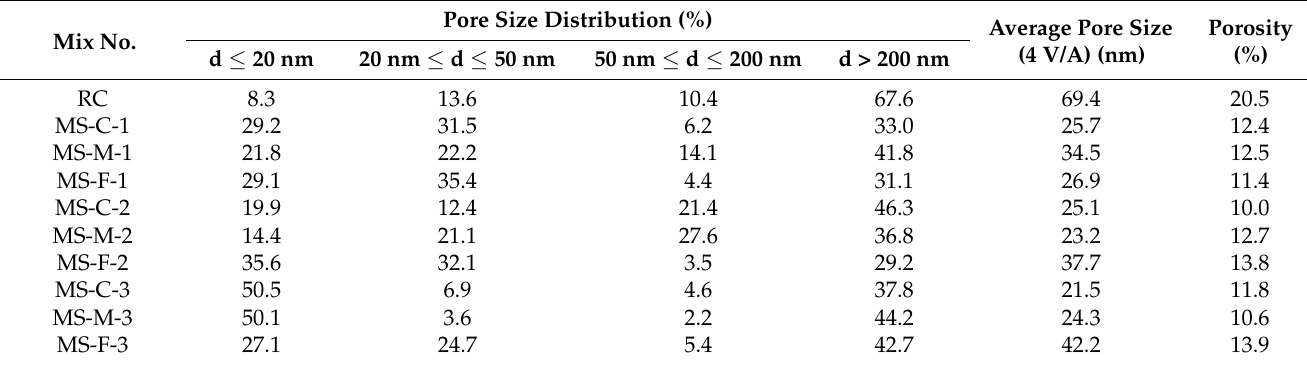
Table 3. Concrete porosity distribution, average pore diameter, and total